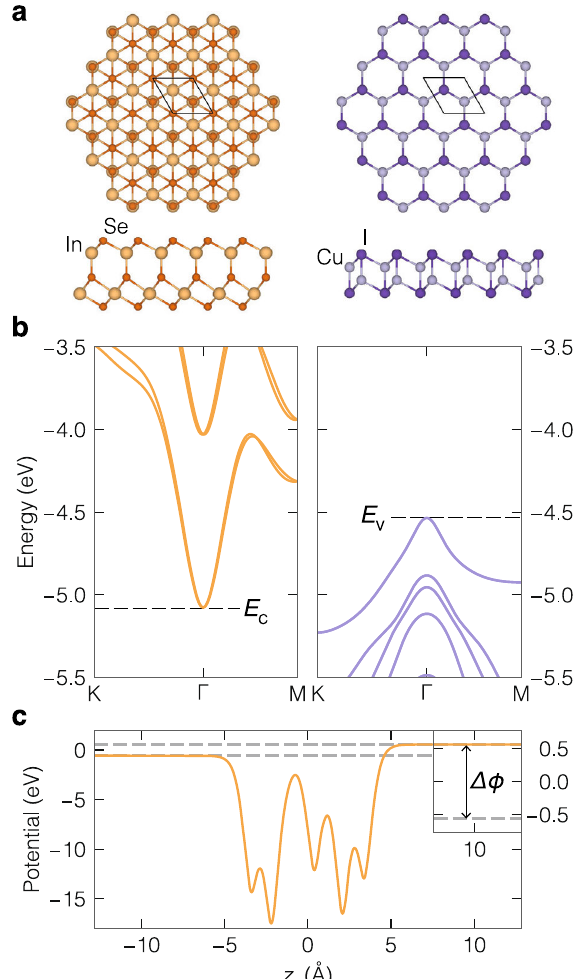
Fig. 2 Crystal and electronic structure of isolated monolayers. a Top and lateral views of the crystal structures of In 2 Se 3 (left) and CuI (right). The primitive unit cell is shown with a thin solid line. b Electronic band structure of the two isolated materials, obtained through PBE-DFT calculations including spin-orbit coupling, in an energy range comprising the bottom conduction bands of In 2 Se 3 (orange, left) and the top valence bands of CuI (violet, right). The zero of energy is set at the potential energy of a plane of uniform charge density. c Planar average of the electrostatic potential energy as a function of the vertical coordinate z across a single layer of In 2 Se 3 . A clear difference in potential energy Δ ϕ between the two sides is present and its magnitude is emphasized in the